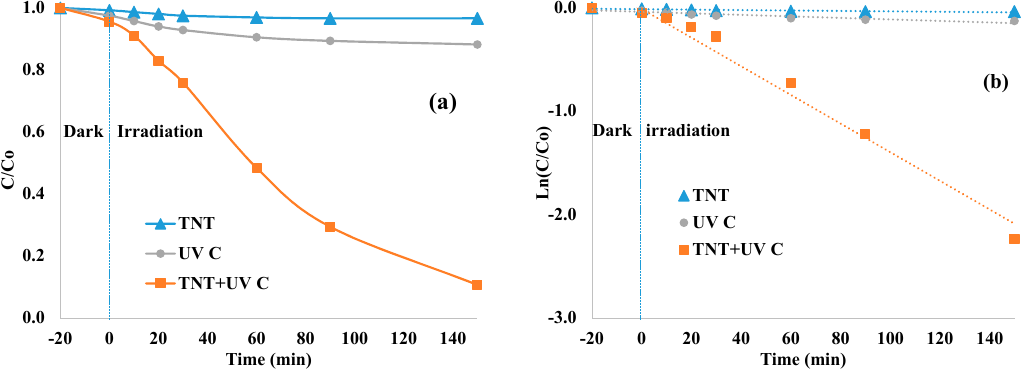
Figure 5. Photocatalytic degradation of MB dye in a continuous ‐ flow experiment over TNTs, UV C, and TNTs + UV C: ( a ) C/C 0 and ( b ) ln(C/C 0 ).